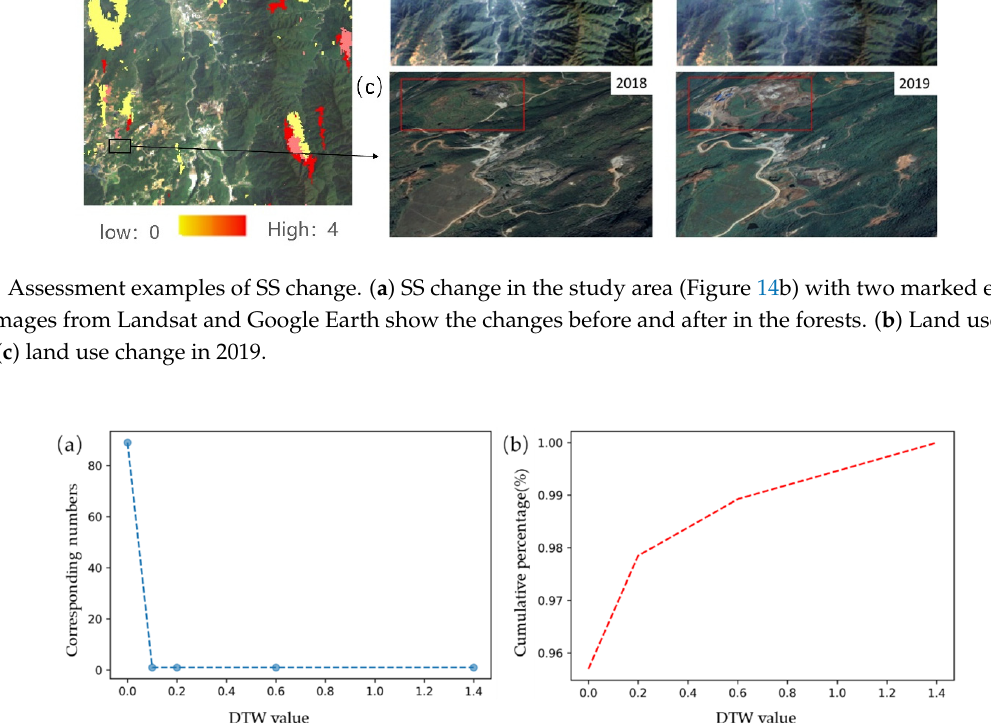
Figure 17. ( a ) Spatial distribution map of the overlap of different types of IST-cubes. ( b ) Different types of IST-cubes overlap areas as a percentage of the total study area. 4. Discussion We improved the spatiotemporal cube model to provide more detailed spatiotem- poral information on forest dynamics and obtained different spatiotemporal scale IST- cubes. Different changes cause different IST-cubes. Consequently, combining the spatial distribution and spatiotemporal features of different IST-cubes can capture the multi-scale spatiotemporal changes in the forests. Our method was tested in a forest rich in mineral resources in China. We mapped the spatial distribution of the IST-cubes at different spa- tiotemporal scales and analyzed their causes.